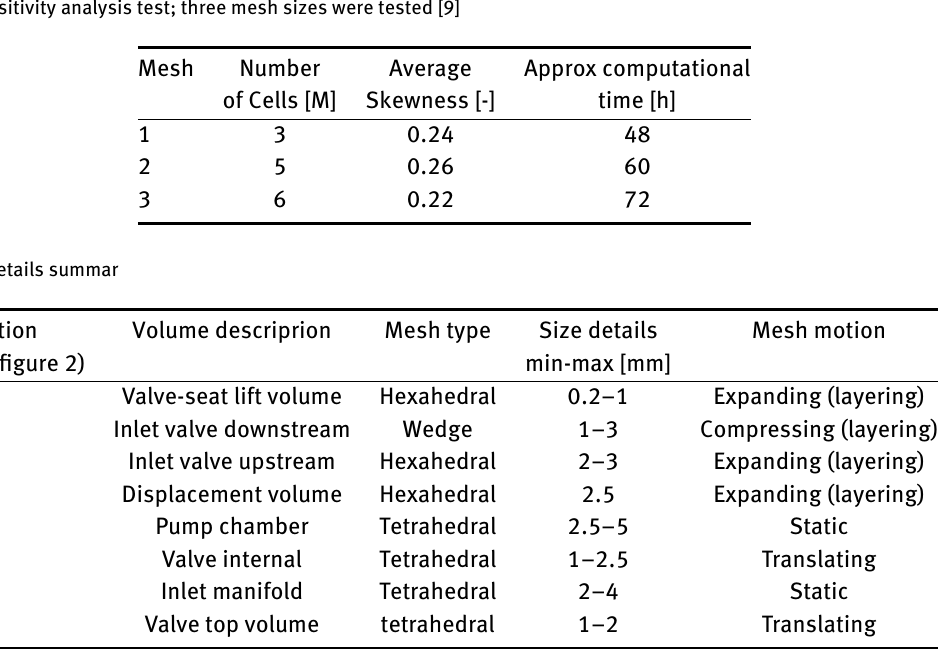
Table 1: Mesh sensitivity analysis test; three mesh sizes were tested [9]